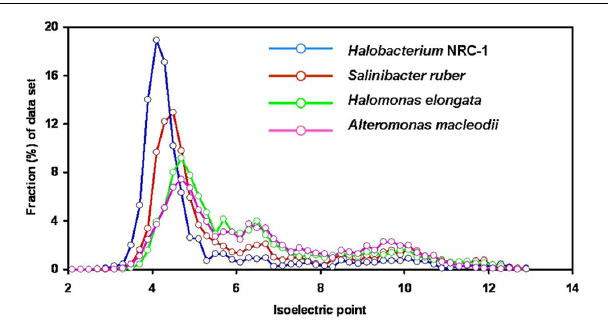
FIGURE 1 | Isoelectric point profiles, calculated at 0.2 intervals, of predicted proteins encoded by the genomes of Halobacterium NRC-1 (2,675 proteins; median pI 5.03), the extreme halophilic bacterium Salinibacter ruber (2,845 proteins; median pI 5.92), the aerobic moderately halophilic bacterium Halomonas elongata (3,474 proteins; median pI 6.32) and the aerobic marine bacterium Alteromonas macleodii (4,396 proteins; median pI 6.46) . From the genome annotations (Ng etal., 2000; Mongodin etal., 2005; Schwibbert etal., 2011) sequences encoding proteins or putative proteins were extracted, and for each protein sequence the predicted the pI value was calculated using the programs in the Galaxy platform (http://main.g2.bx.psu.edu; Giardine etal., 2005; Blankenberg etal., 2010; Goecks etal., 2010).With kind